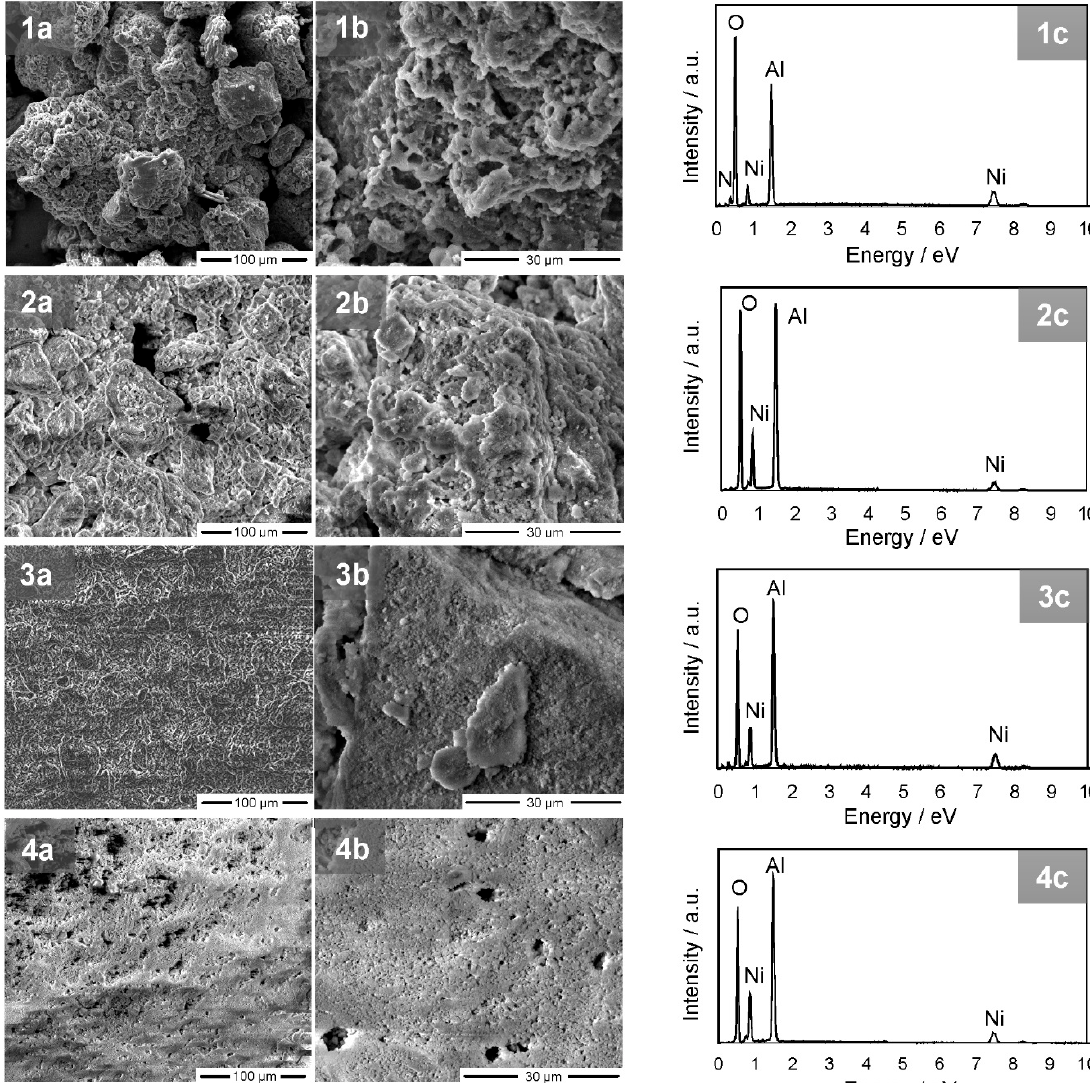
Figure 4. Scanning electron microscopy (SEM) images and X-ray (EDX) spectra of NiAl 2 O 4 without ( 1a – c ) and after annealing at ( 2a – c ) 400, ( 3a – c ) 600 and ( 4a – c ) 800 °C.